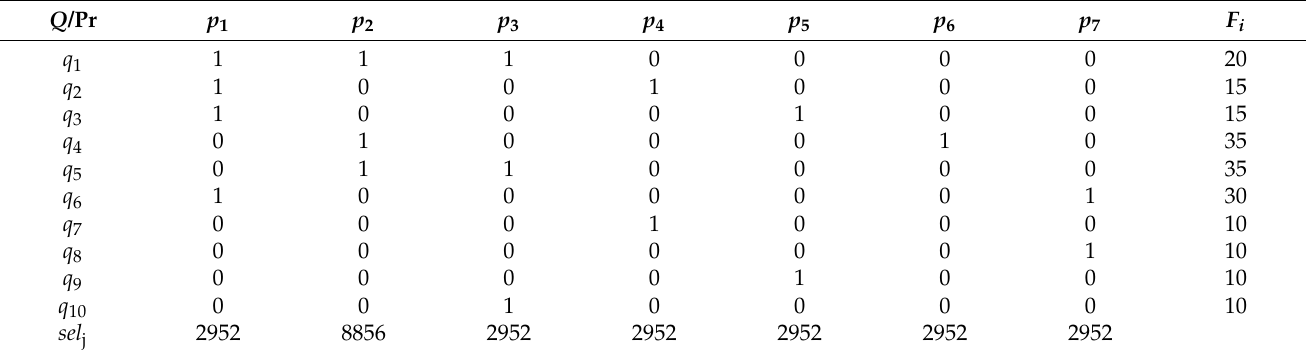
Table 10. Predicate usage matrix for the first experiment.